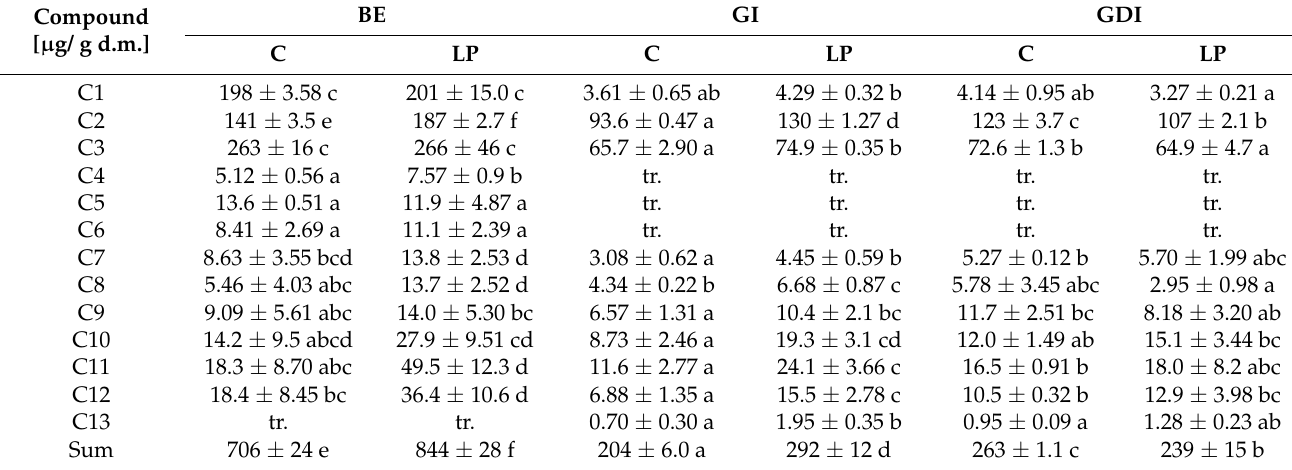
Means ( ± SD) in columns followed by different letters are significantly different ( n = 9; p ≤ 0.05). C—control sprouts, LP—sprouts enriched with the probiotic, BE—buffer extract, GD—extract after gastric digestion, GDI—extract after gastrointestinal